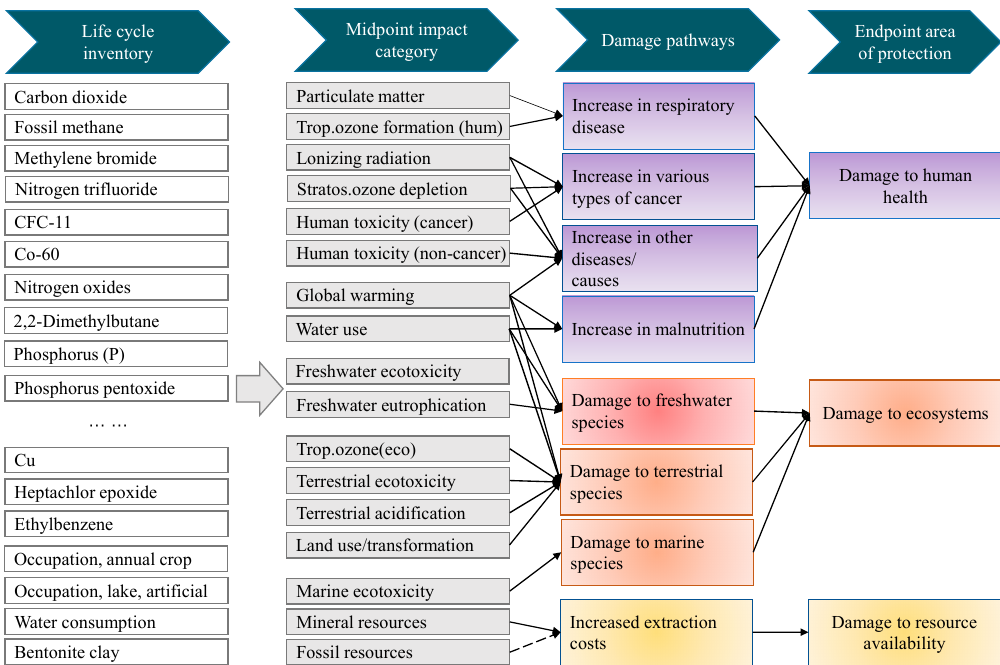
Figure 2. Life cycle assessment (LCA) analysis flowchart for ReCiPe2016 method expended from Reference [46]. The dotted line means there is no constant mid-to endpoint factor for fossil resources.